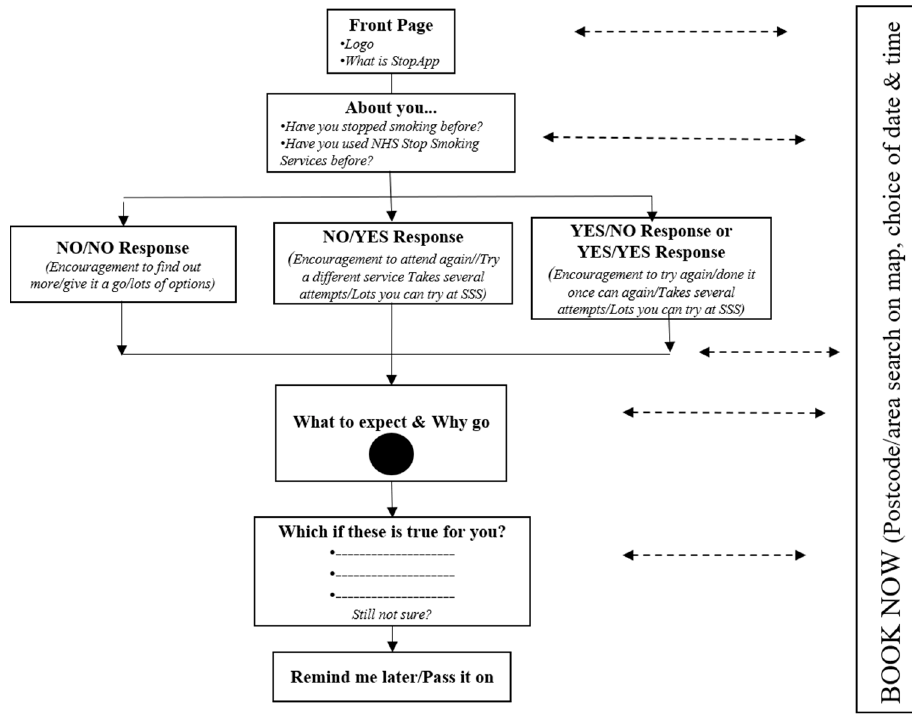
Figure 2. Flowchart of basic StopApp structure.